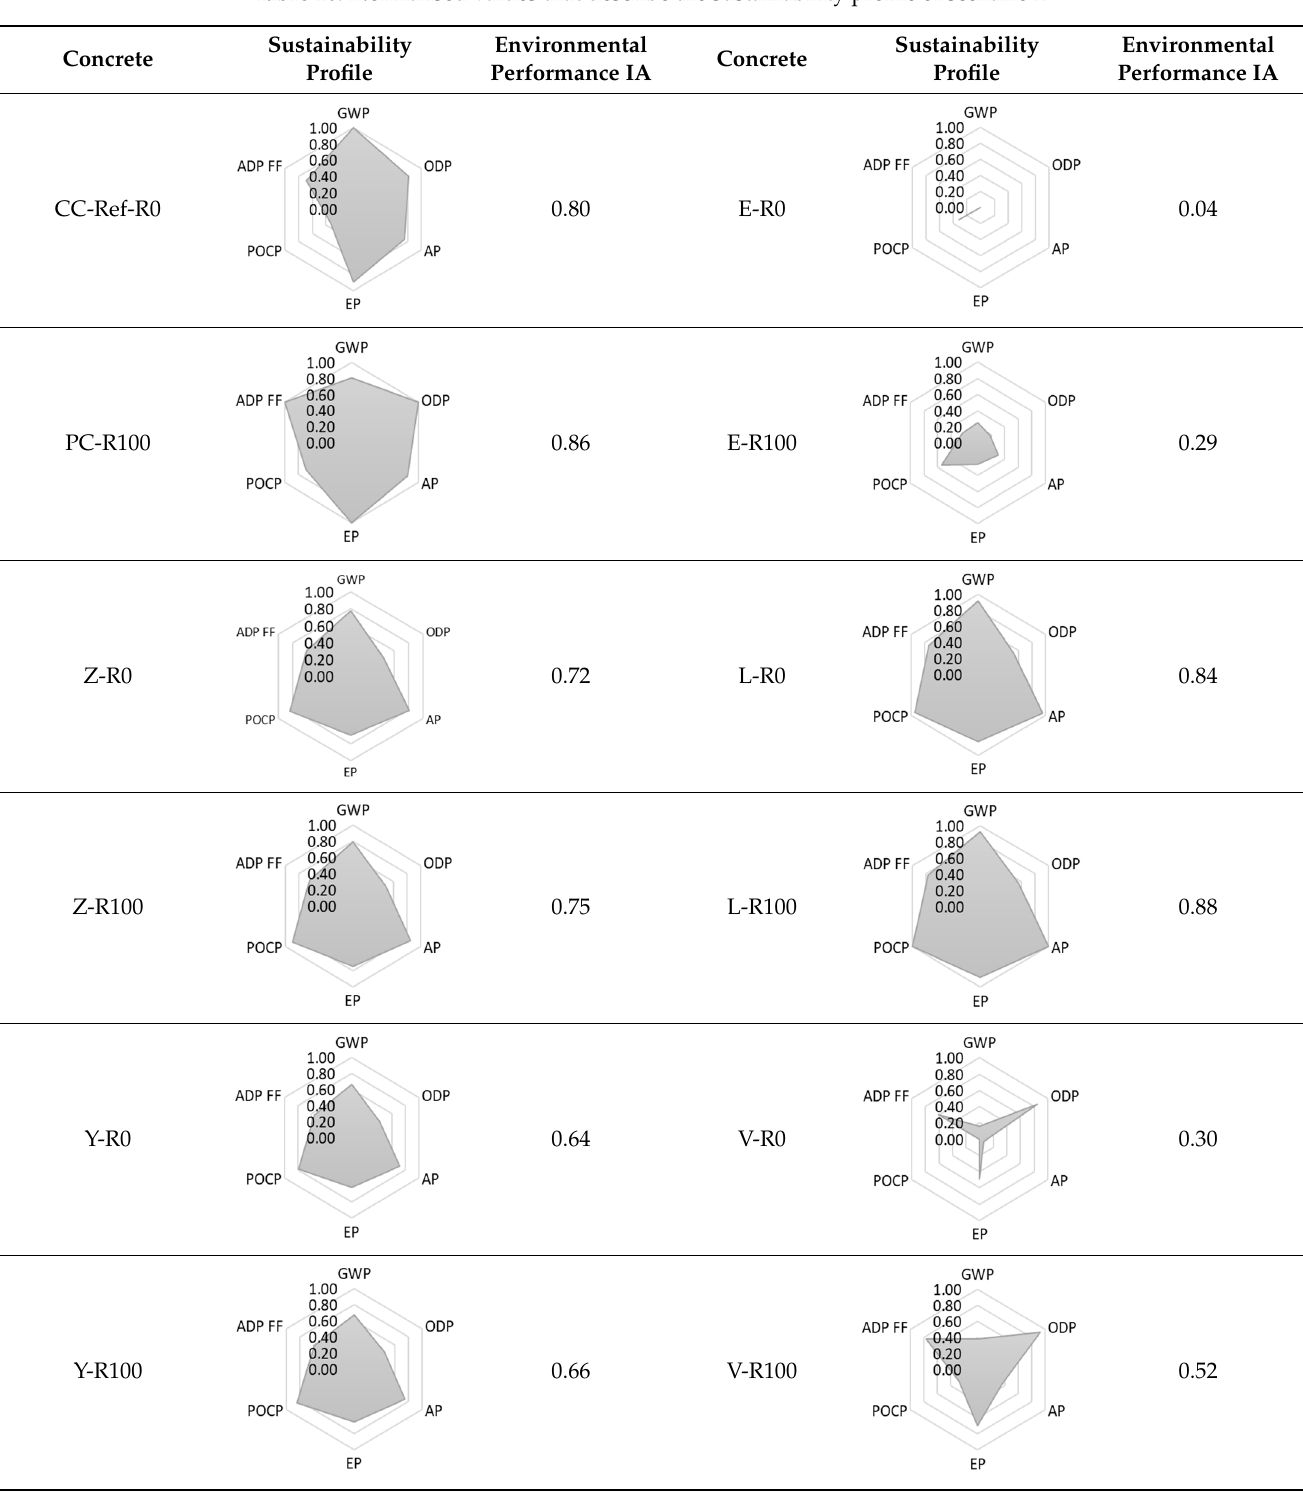
Table 16. Normalised values that describe the sustainability profile of scenario 2.